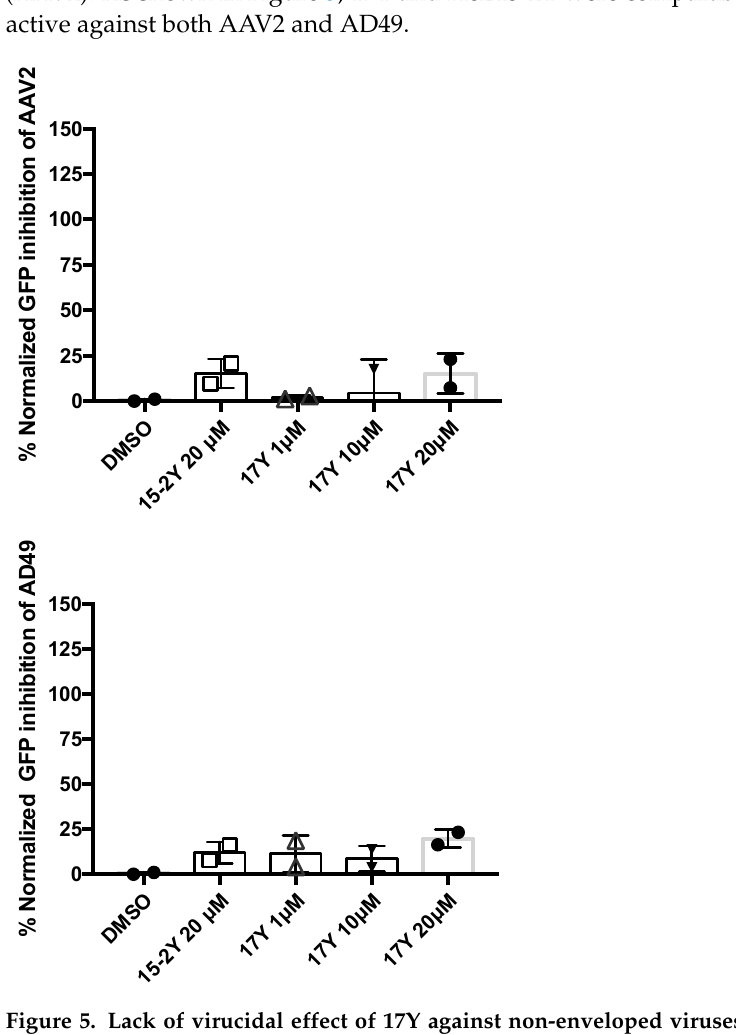
Figure 5. Lack of virucidal effect of 17Y against non-enveloped viruses: AAV2 and AD49 were pre-treated for 1 h with 17Y or negative control HeE15-2Y at the indicated concentrations. HEK293T cells were then infected for 24 h for AD49 and 48 h for AAV2. Inhibition (%) was calculated as GFP signal normalized over vehicle (DMSO). Columns and bars represent the average and STDV from replicates (the result of each measure is reported using circle, square or triangle symbols).